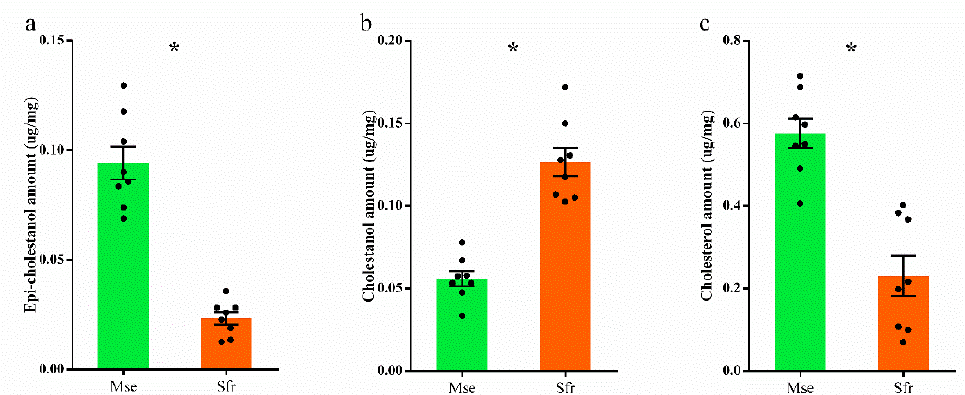
Figure 6. Body steroid profiles in Mythimna separata and Spodoptera frugiperda on cholestanone. Three sterols, ( a ) epi-cholestanol, ( b ) cholestanol, and ( c ) cholesterol were detected. Data are calculated from five biological replicates and shown as means ± standard errors. * indicates significant differences between M . separata and S . frugiperda at p < 0.05.